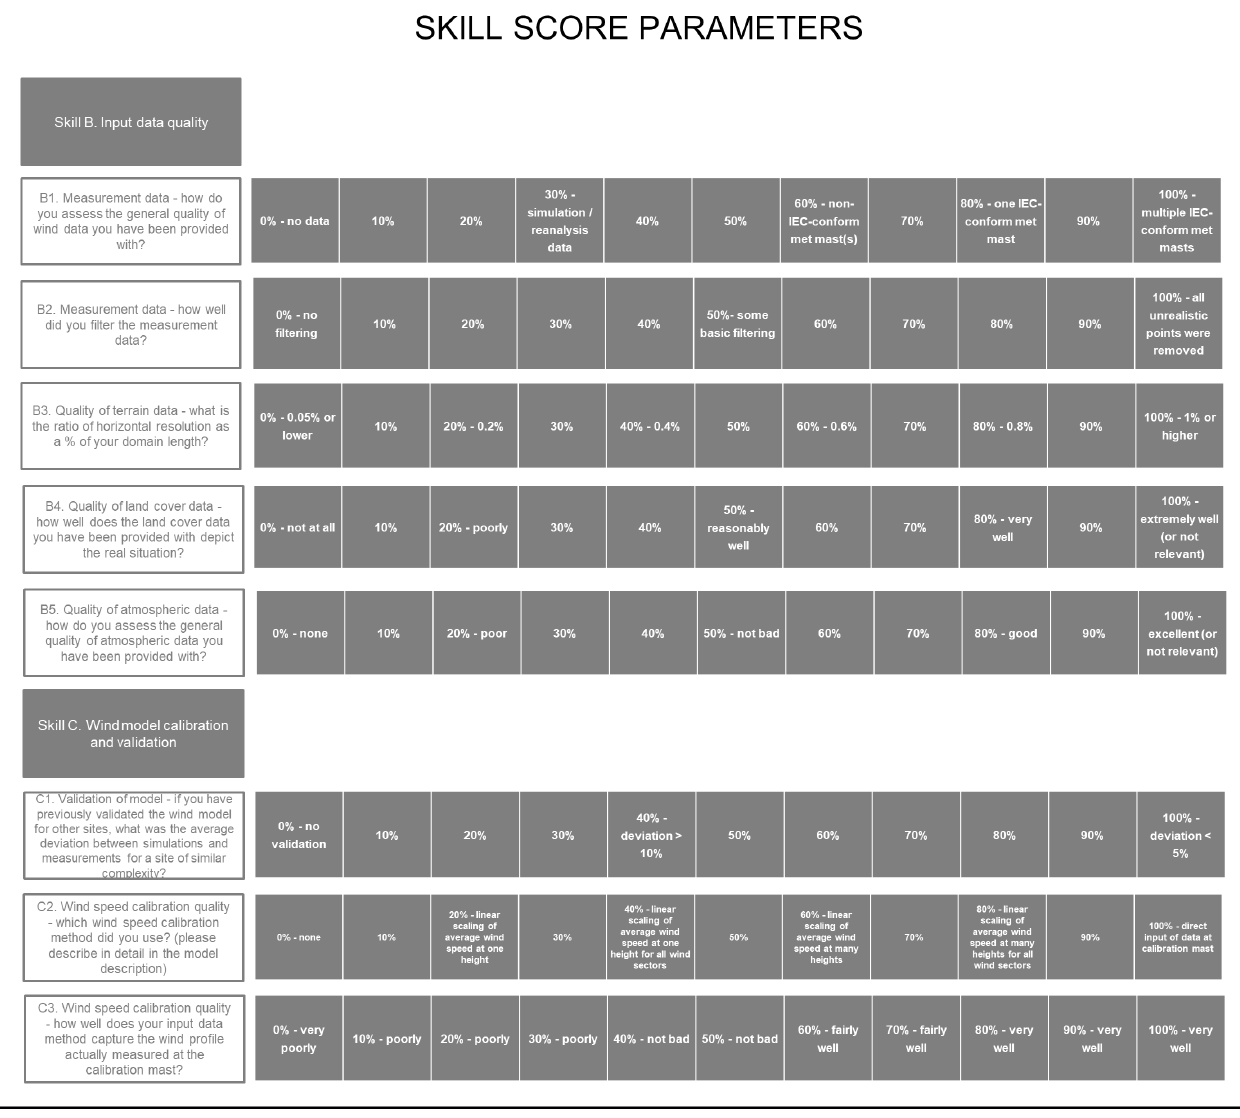
Figure A2. Scales assigned to each skill parameter (Skills B and